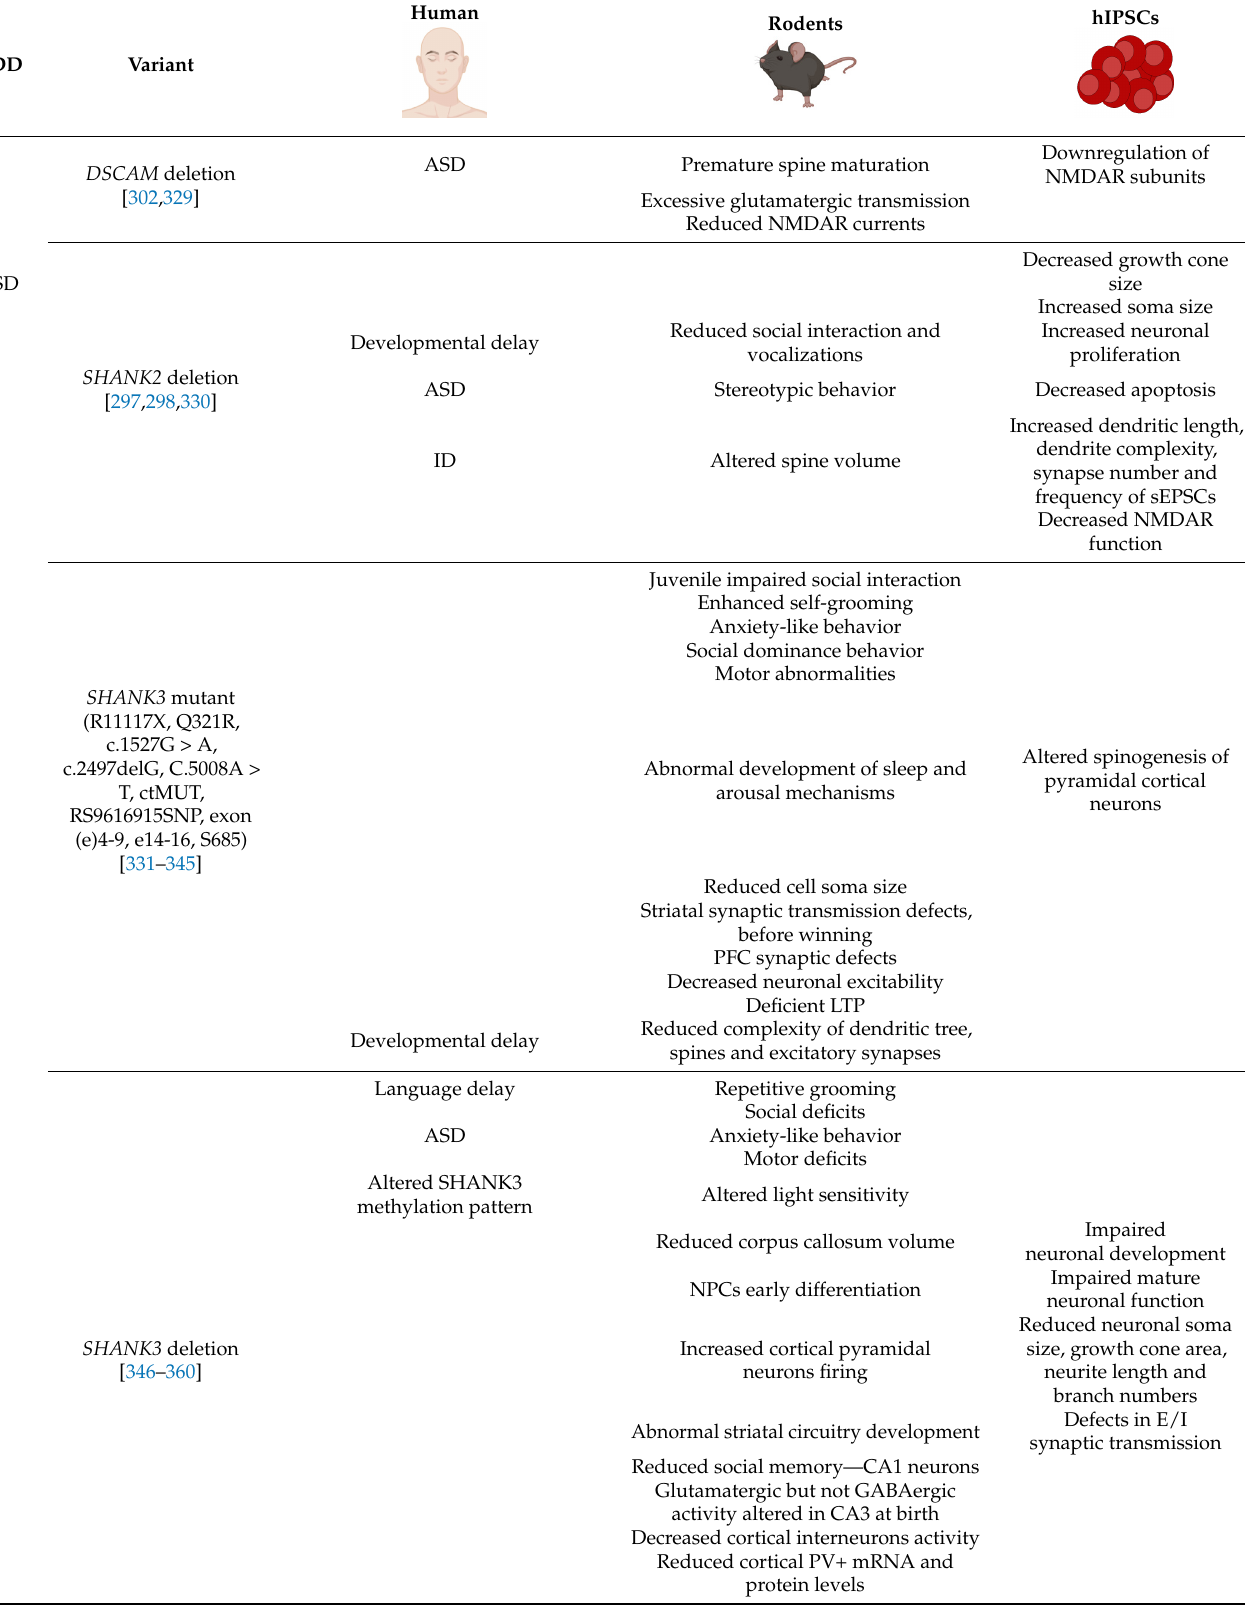
Table 3. Described ASD human, rodent and hIPSCs phenotypes.